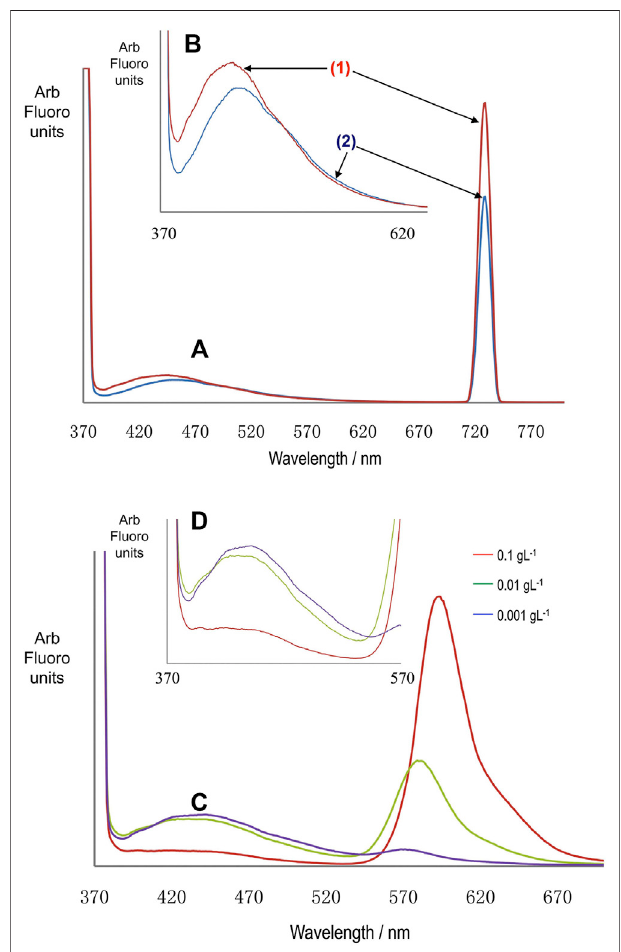
FIGURE 15 | Graphs (A,B) are emission spectra for BEICs from two different batches [(1) and (2)] of spores. Spectrum (B) is an expansion of the 370 – 650 nm range of the spectrum (a). The peak emission wavelength for (2) is 444 nm and for (1) 449 nm. Graphs (C,D) are spectra of the BEICs treated with aqueous solutions of rhodamine B at the concentrations shown. Graph (D) is an expansion of the region 370 – 570 nm of graph (C) . Excitation wavelength is 365 nm for all of the